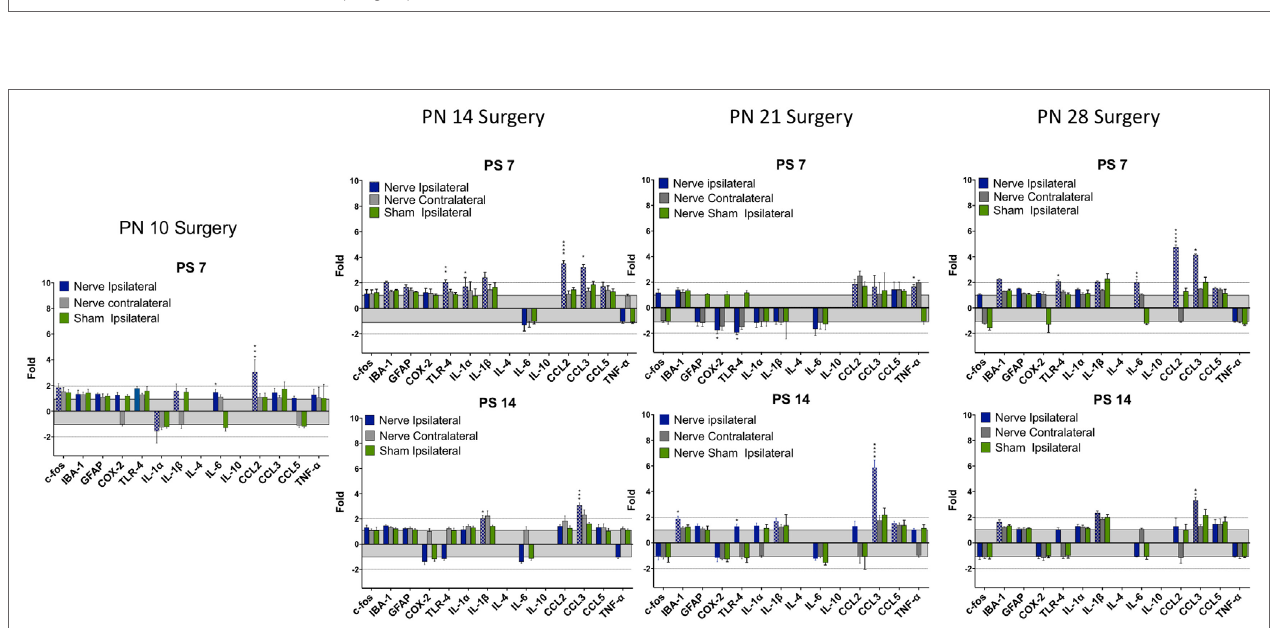
FigUre 4 | change in mrna for immune related markers, cytokines, and chemokines at different times post-root compression at different ages in the dorsal horn of the spinal cord . Note the change in the Y -axis scale for different postsurgical times. Asterisks denote statistical differences between the side ipsilateral to the compression and the ipsilateral side of the sham animals (see Figure 2 ). Also shown, but not tested statistically are the dorsal horn data contralateral to the injury. All fold change in the side ipsilateral to the injury are shown by hatched bars. The gray area bounds ± 1.0 for which there are no values. The dashed lines are twofold levels. N = 4 per